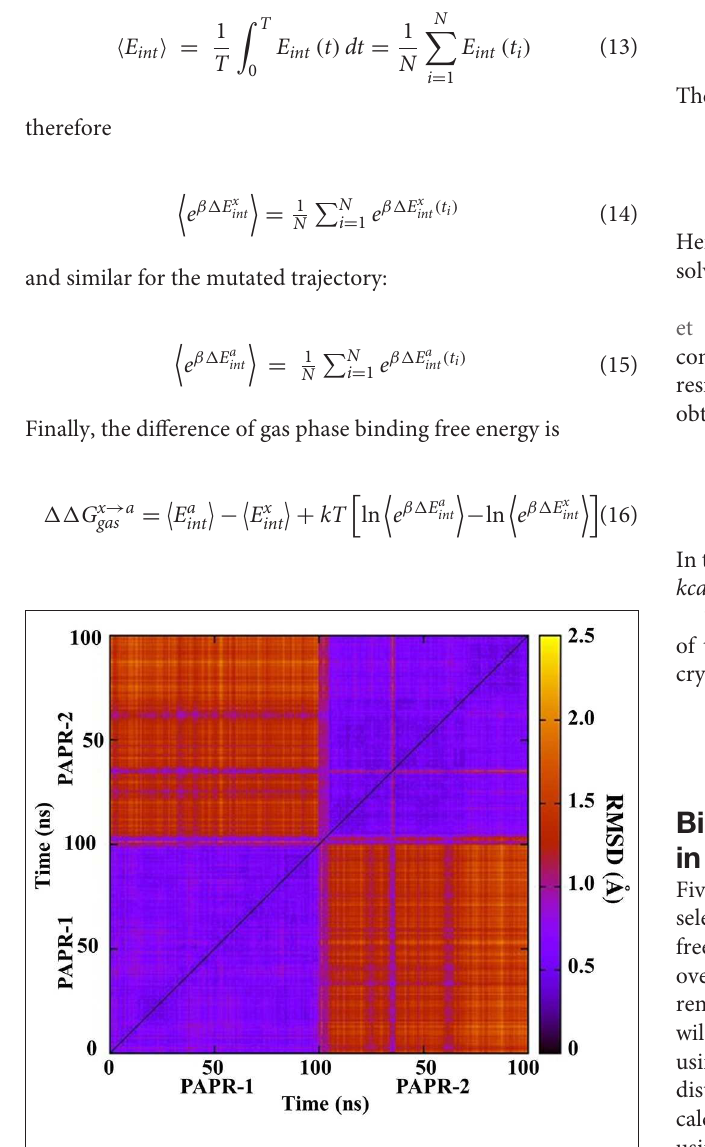
FIGURE 5 | 2D-RMSD of PARP-1 and PARP-2 during simulations.